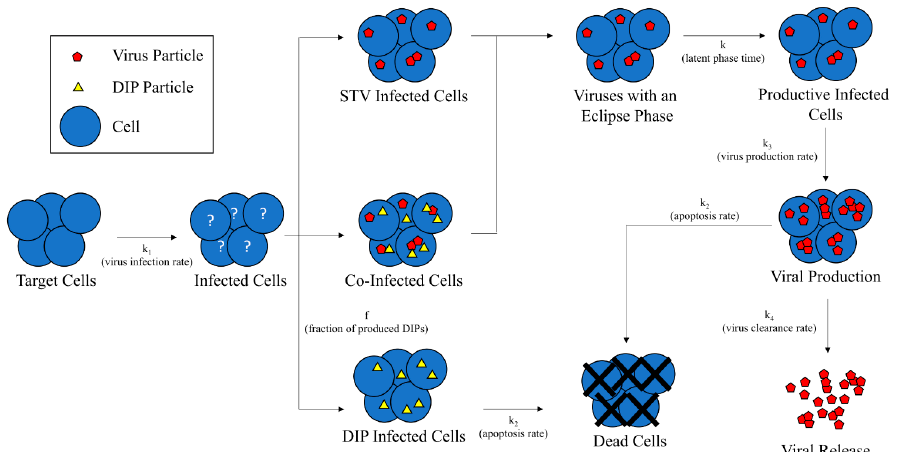
Figure 1. Model flow diagram: The chart above gives a schematic view of the mathematical model that has been proposed. From left to right, the diagram shows the possible progression of a healthy cell infected by both standard viral particles and defective interfering particles (DIPs). The diagram also shows the addition of a viral latent or eclipse phase.